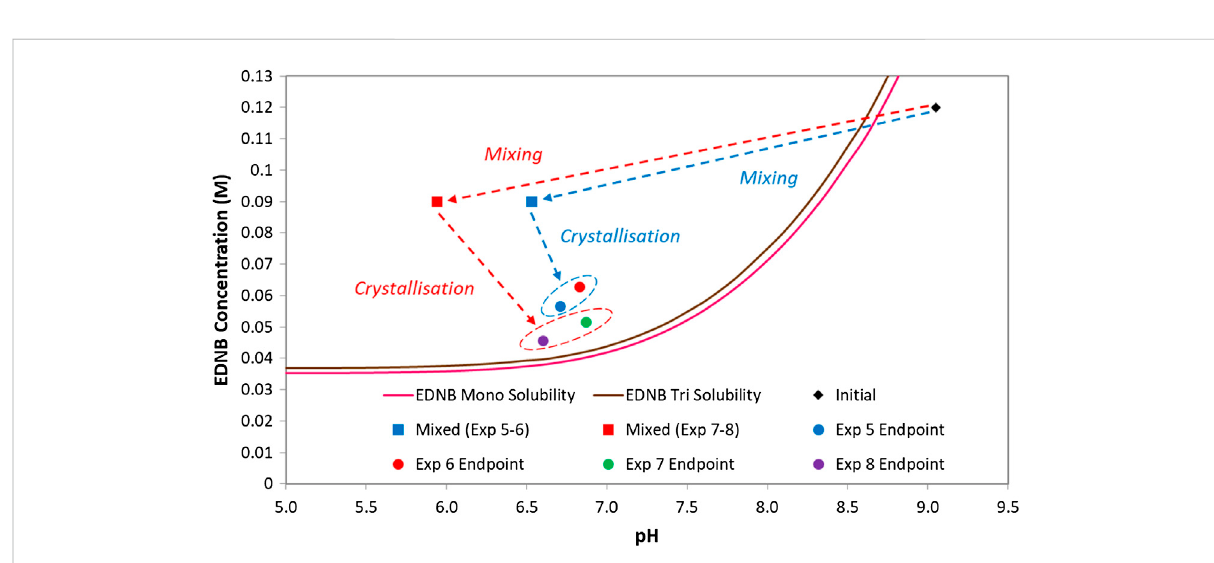
FIGURE 10 Crystallisation processes for all of the X-mixer and MSMPR cascade experiments.